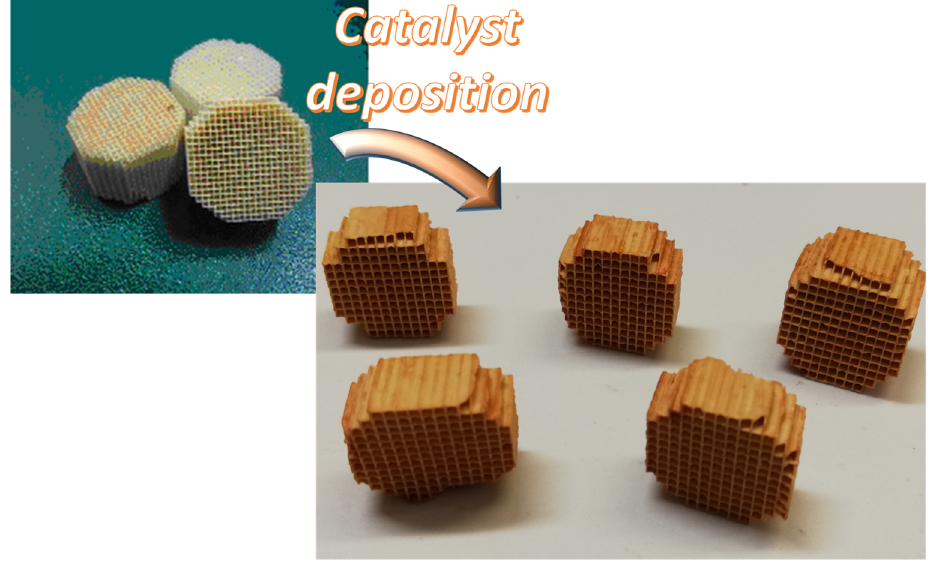
Figure 1. Picture of blank and prepared